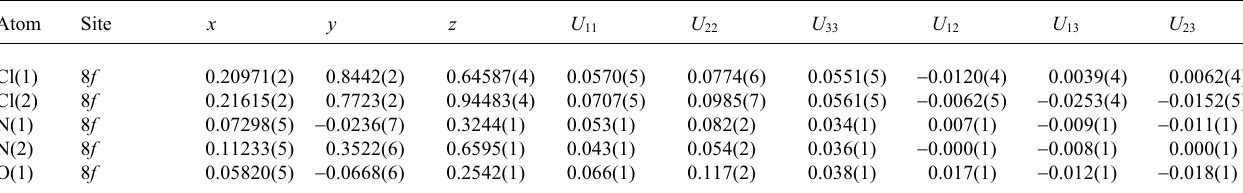
Table 3. Atomic coordinates and displacement parameters (in Å 2